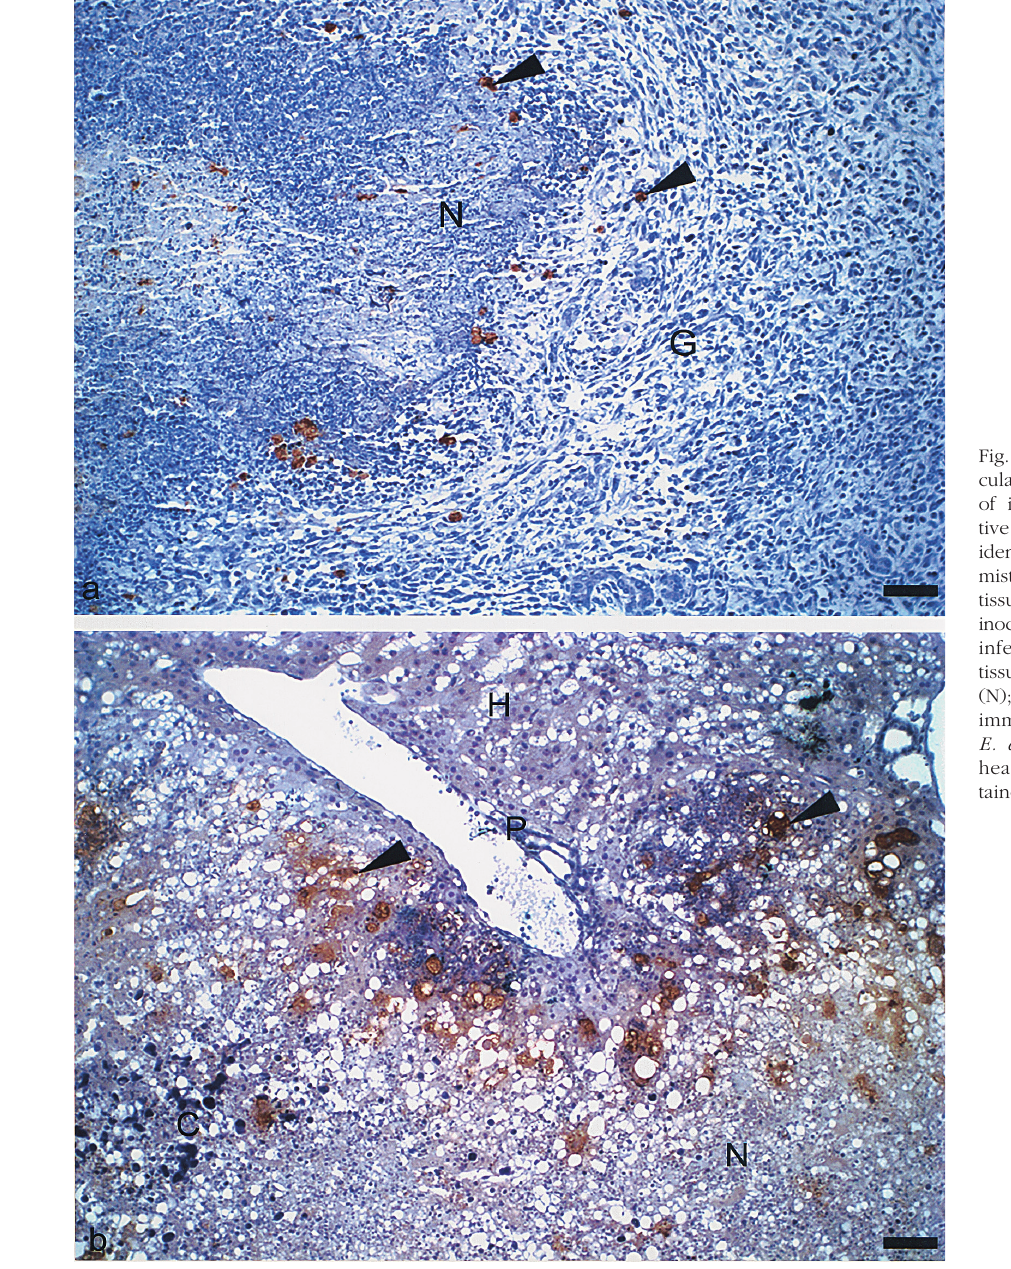
Fig. 1. – (a) Livers of hamsters ino- culated with E. histolytica (3 rd day of infection). Necrosis (N); posi- tive trophozoites of E. histolytica identified for the immunohistoche- mistry (arrowheads); granulation tissue (G); (b) Livers of hamsters inoculated with E. dispar (3 rd day of infection) . Degenerated hepatic tissue (H); portal tract (P); necrosis (N); calcification zones (C); several immunohistochemically positive E. dispar trophozoites (arrow- heads). Haematoxylin counters- tained. Bar = 100